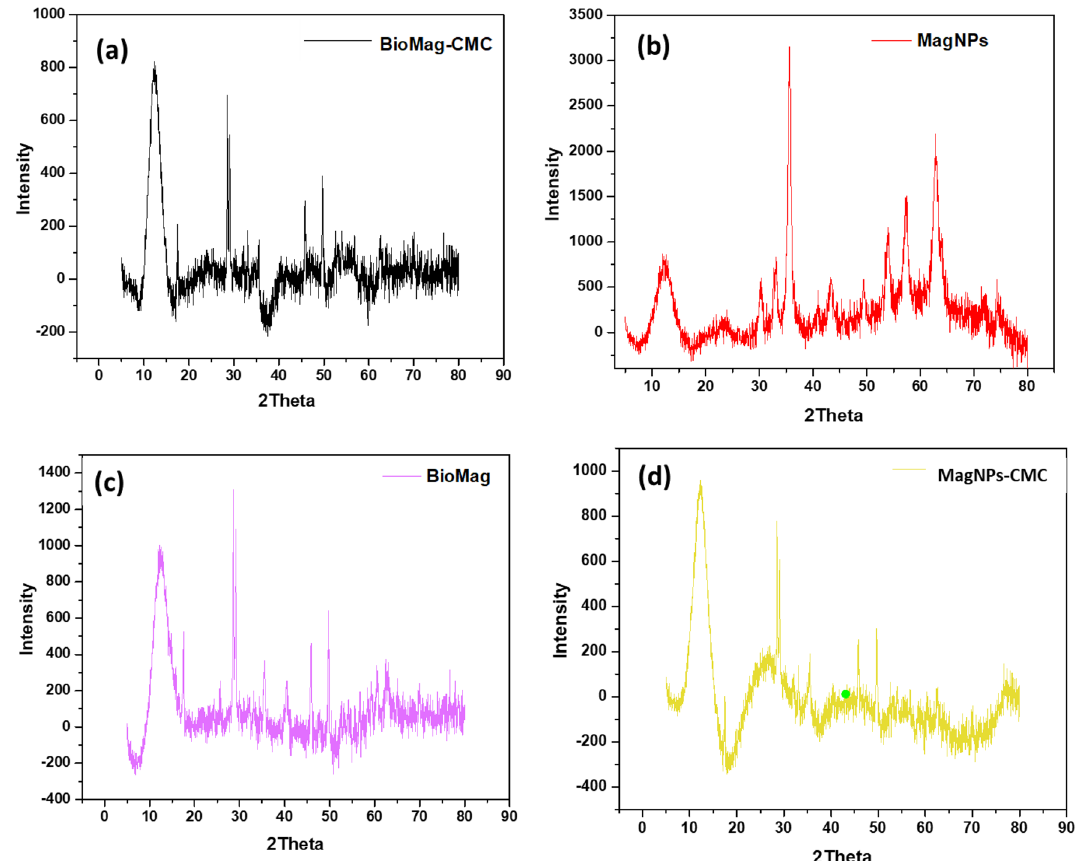
Figure 2. XRD pattern ( a ) BioMag-CMC, ( b ) MagNPs-CMC, ( c ) BioMag and ( d )